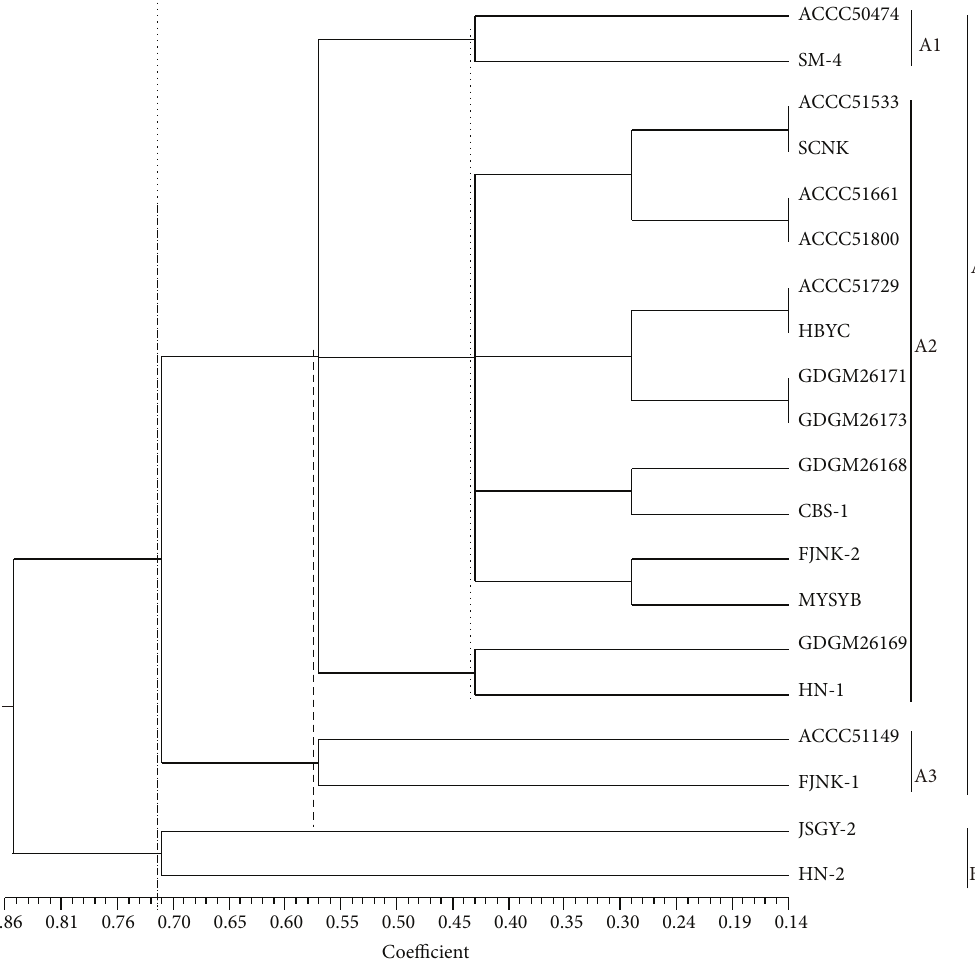
Figure 2: Phylogenetic tree based on TRAP data. The Hypsizygus marmoreus strains were classified into two subgroups at Jaccard’s similarity coefficient of 0.718. Group B included strains of JSGY-2 and HN-2. Group A had the remaining 18 strains. Group A was classified into 3 subgroups at Jaccard’s coefficients of 0.575 and